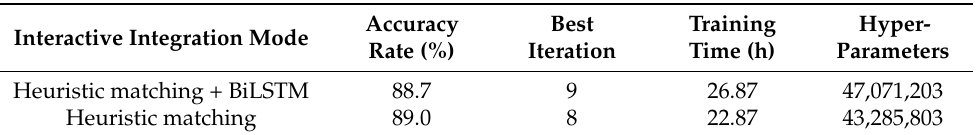
Table 6. Comparison of the influence of different interactive fusion methods on semantic fusion depth matching network.